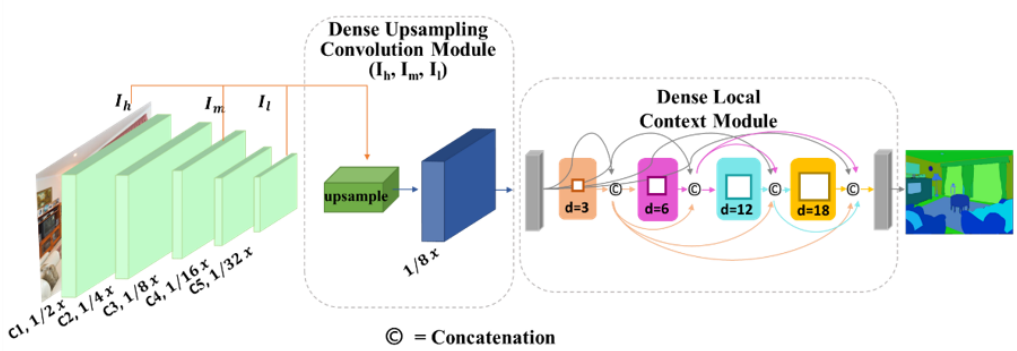
Figure 2. Network overview: The DUC is implemented after the last convolutional layer of the backbone network to upsample the low-resolution feature map into a high-resolution feature map by transferring structural details from the high-resolution guidance image. The DLC is used on the output of the DUC layer in order to extract dense multi-scale local contextual representations. Best viewed in color.